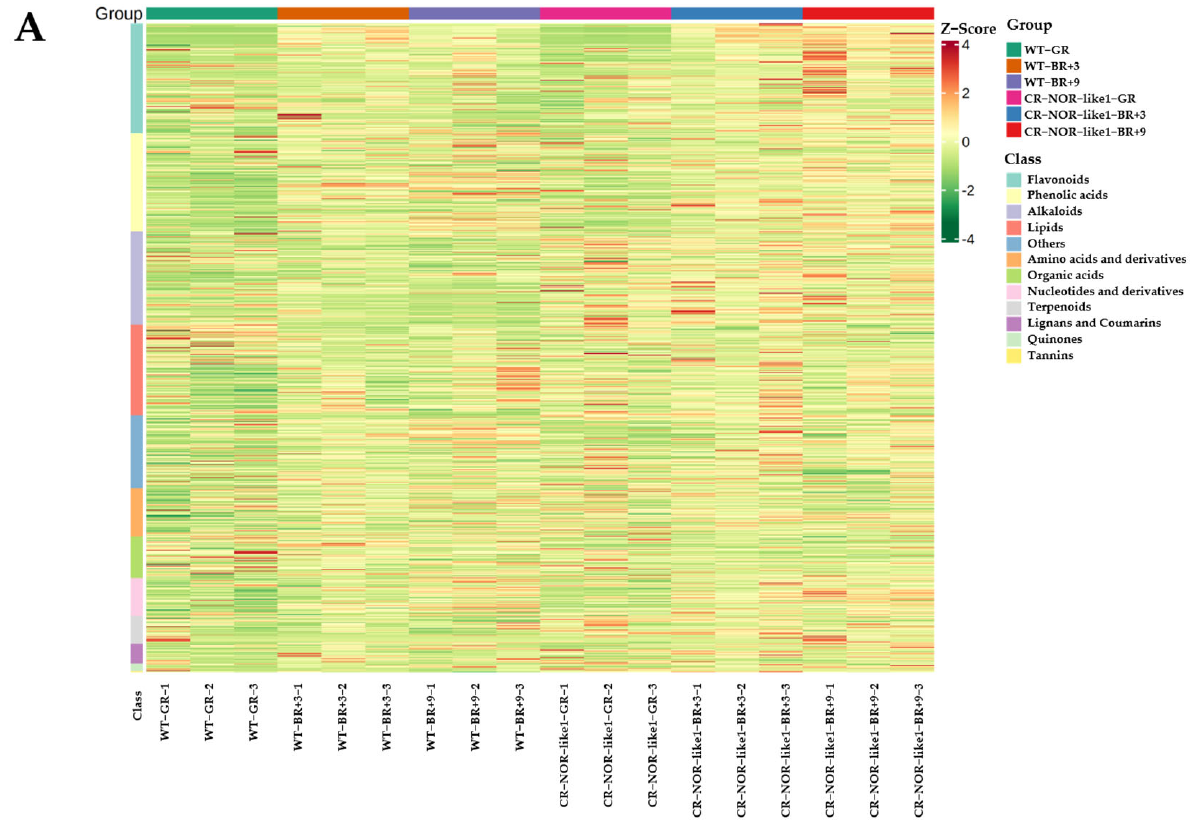
Figure 2. ( A ) Cluster heat map of differential ‐ metabolite content; horizontal is the sample name, vertical is the metabolite information, Group is the grouping, Class is the substance classification, and different colors are the values obtained after normalization of the relative content (red repre ‐ sents high content, green represents low content). ( B ) K ‐ means clustering diagram of differential metabolites; the horizontal coordinate indicates the sample name, the vertical coordinate indicates the normalized relative metabolite content, Sub Class represents the metabolite class number with the same trend of change, and total represents the number of metabolites in the class as.